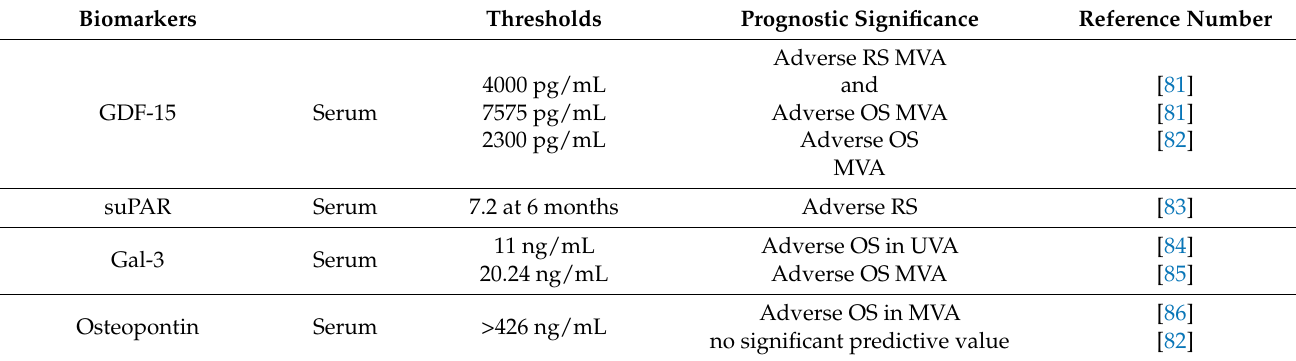
Table 4. Prognostic significance of novel biomarkers in AL amyloidosis. GDF-15, growth differentiation factor-15; suPAR, soluble urokinase-type plasminogen receptor; Gal-3, galectin-3; vWF, von Willebrand factor; RDW, red cell distribution width; sST2, soluble suppression of tumorigenicity 2; LV, left ventricle; ECV, extracellular volume; FMD, flow-mediated dilatation; MRI, magnetic resonance tomography; MCF, myocardial contraction fraction of the LV; LAS, longitudinal axis strain; RS, renal survival; MVA, multivariate analysis; OS, overall survival; UVA, univariate